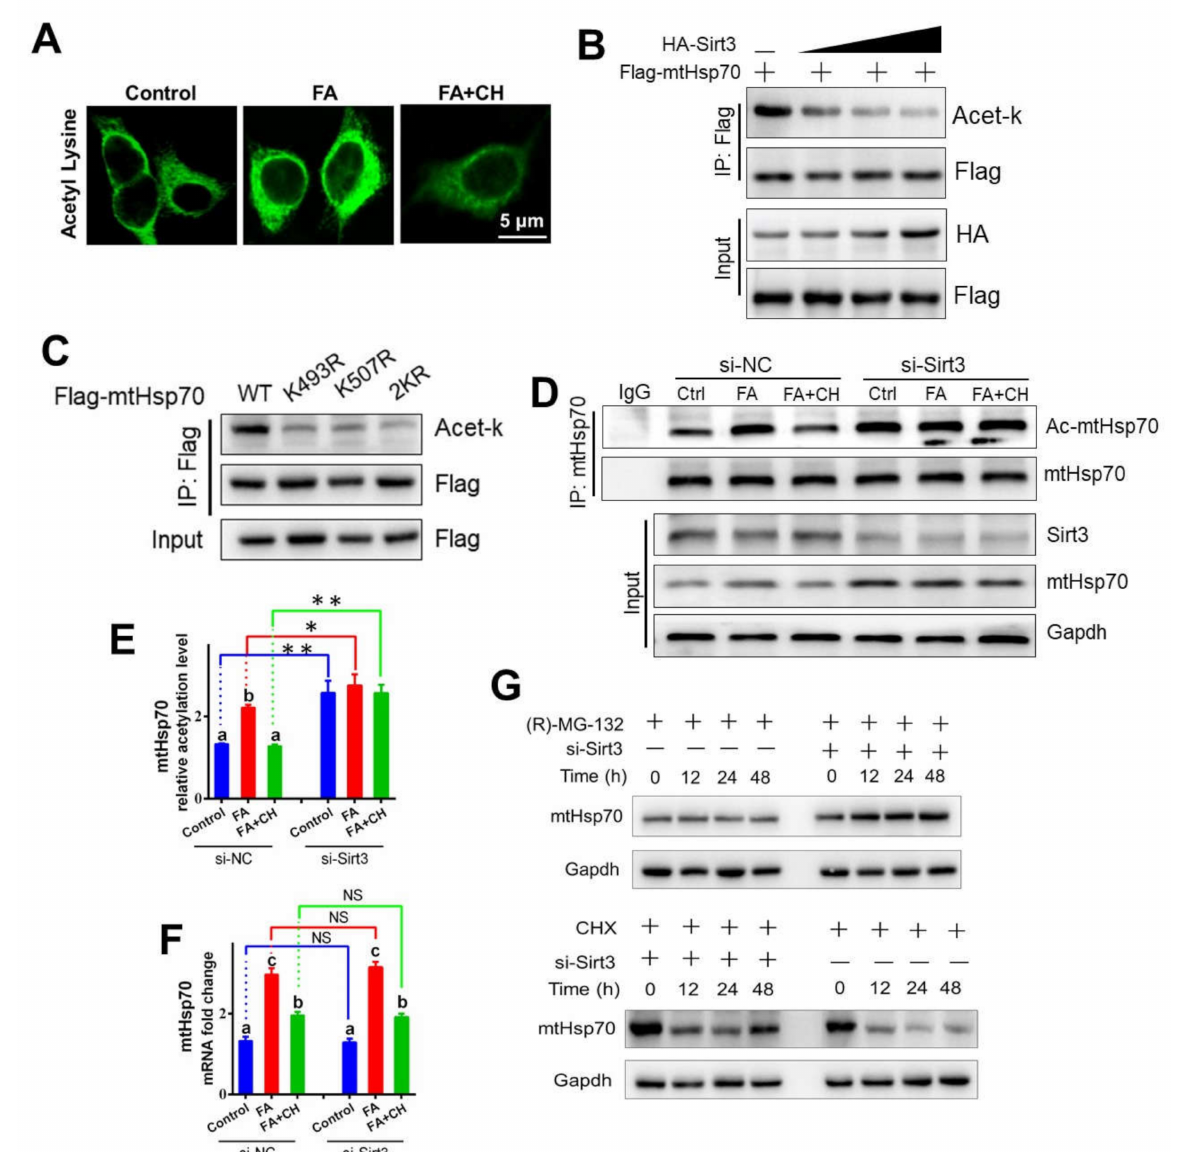
Figure 4. Choline-inhibited FA increased the stability of mtHSP70 via SIRT3-mediated deacetylation in vitro. ( A ) Immunofluorescent analysis of acetylation after the anti-acetyl lysine antibody (green) in hepatocytes of yellow catfish. Bars represent 5 µ m. ( B ) Overexpression of SIRT3 decreased the acety- lation level of mtHSP70. Different doses of HA-tag SIRT3 and FLAG-tag mtHSP70 were transfected into the HepG2 cell line. The acetylation level of mtHSP70 was determined with immunoprecipitation and Western blot analysis. ( C ) Mutations of K493R and K507R decreased the mtHSP70 acetylation level. The acetylation of ectopically expressed WT, K493R, K507R, and 2KR was analyzed. ( D ) The hepatocytes of yellow catfish were transfected with SIRT3 siRNA, and then the SIRT3 and mtHSP70 protein levels were detected using Western blot analysis. The acetylation level of mtHSP70 was determined using immunoprecipitation and Western blot analysis. ( E ) The quantitative analysis acetylation level of mtHSP70 in D. ( F ) The mRNA levels of mtHSP70 in the hepatocytes of yellow catfish. ( G ) The hepatocytes of yellow catfish were transfected with SIRT3 siRNA and also treated with (H)-MG-132 or CHX for 48 h, and then the mtHSP70 protein levels were detected using Western blot analysis. Values are mean ± SEM ( n = 3 independent biological experiments); different letters indicate significant differences among same si-NC or si-SIRT3 groups ( p ≤ 0.05); asterisks indicate significant differences between si-NC and si-SIRT3 groups (* p ≤ 0.05; ** p ≤